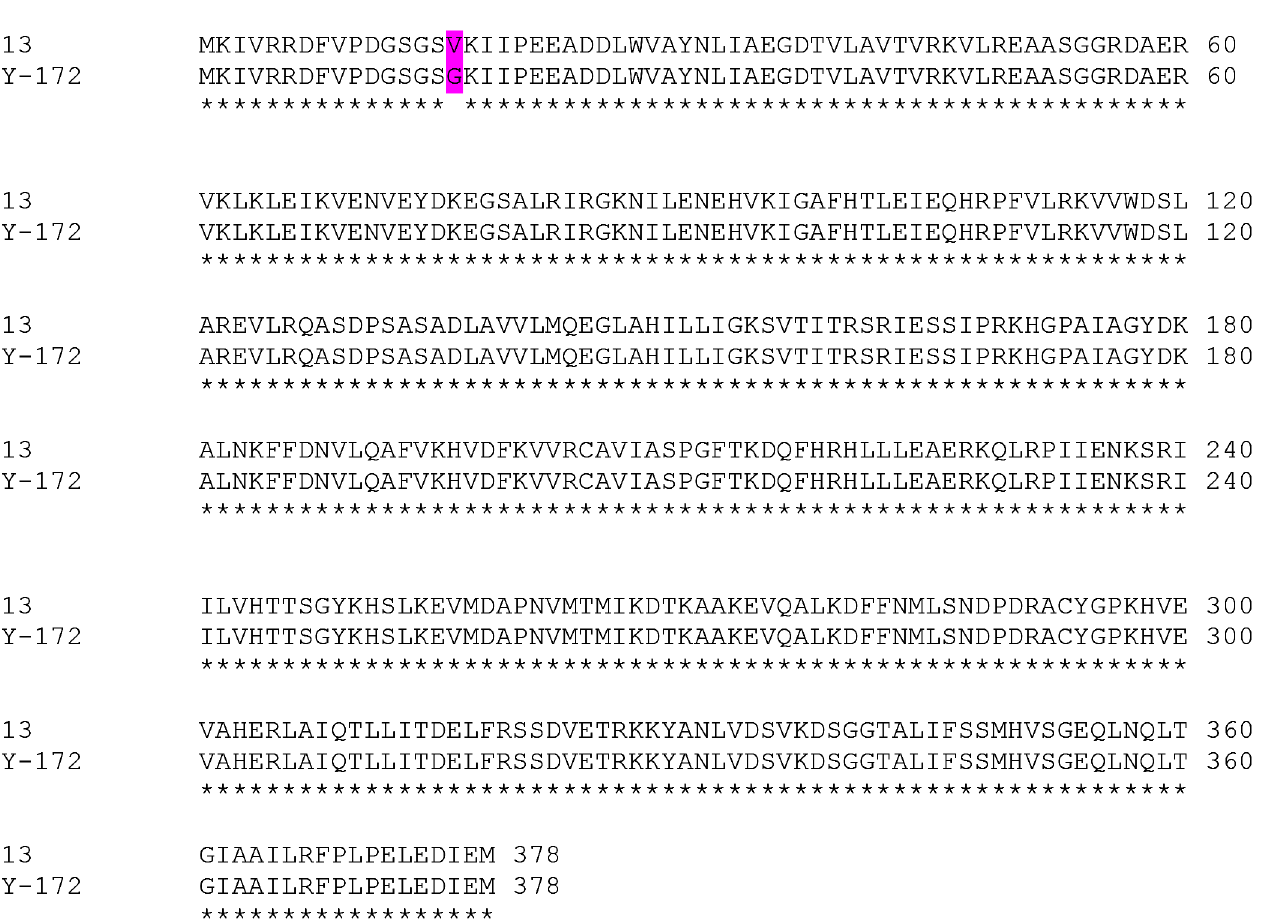
Fig 2. Amino-acid sequence of the Pelo gene in the resistant TY172 line compared to the susceptible line M-82. The substitution of Valine 16 (susceptible lines) to a Glycine (resistant TY172 line) is highlighted with magenta; GenBank accession numbers for TY172 and M-82 are KC447285 and KC447286,